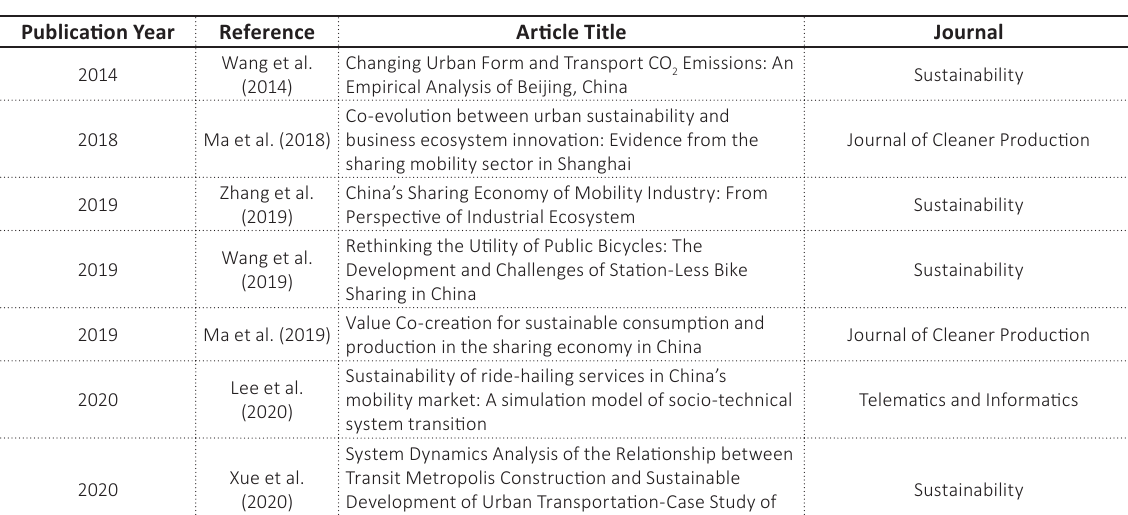
Table 6. Articles retrieved by the keywords “sustainable development”, “sharing economy”, “mobility”, and